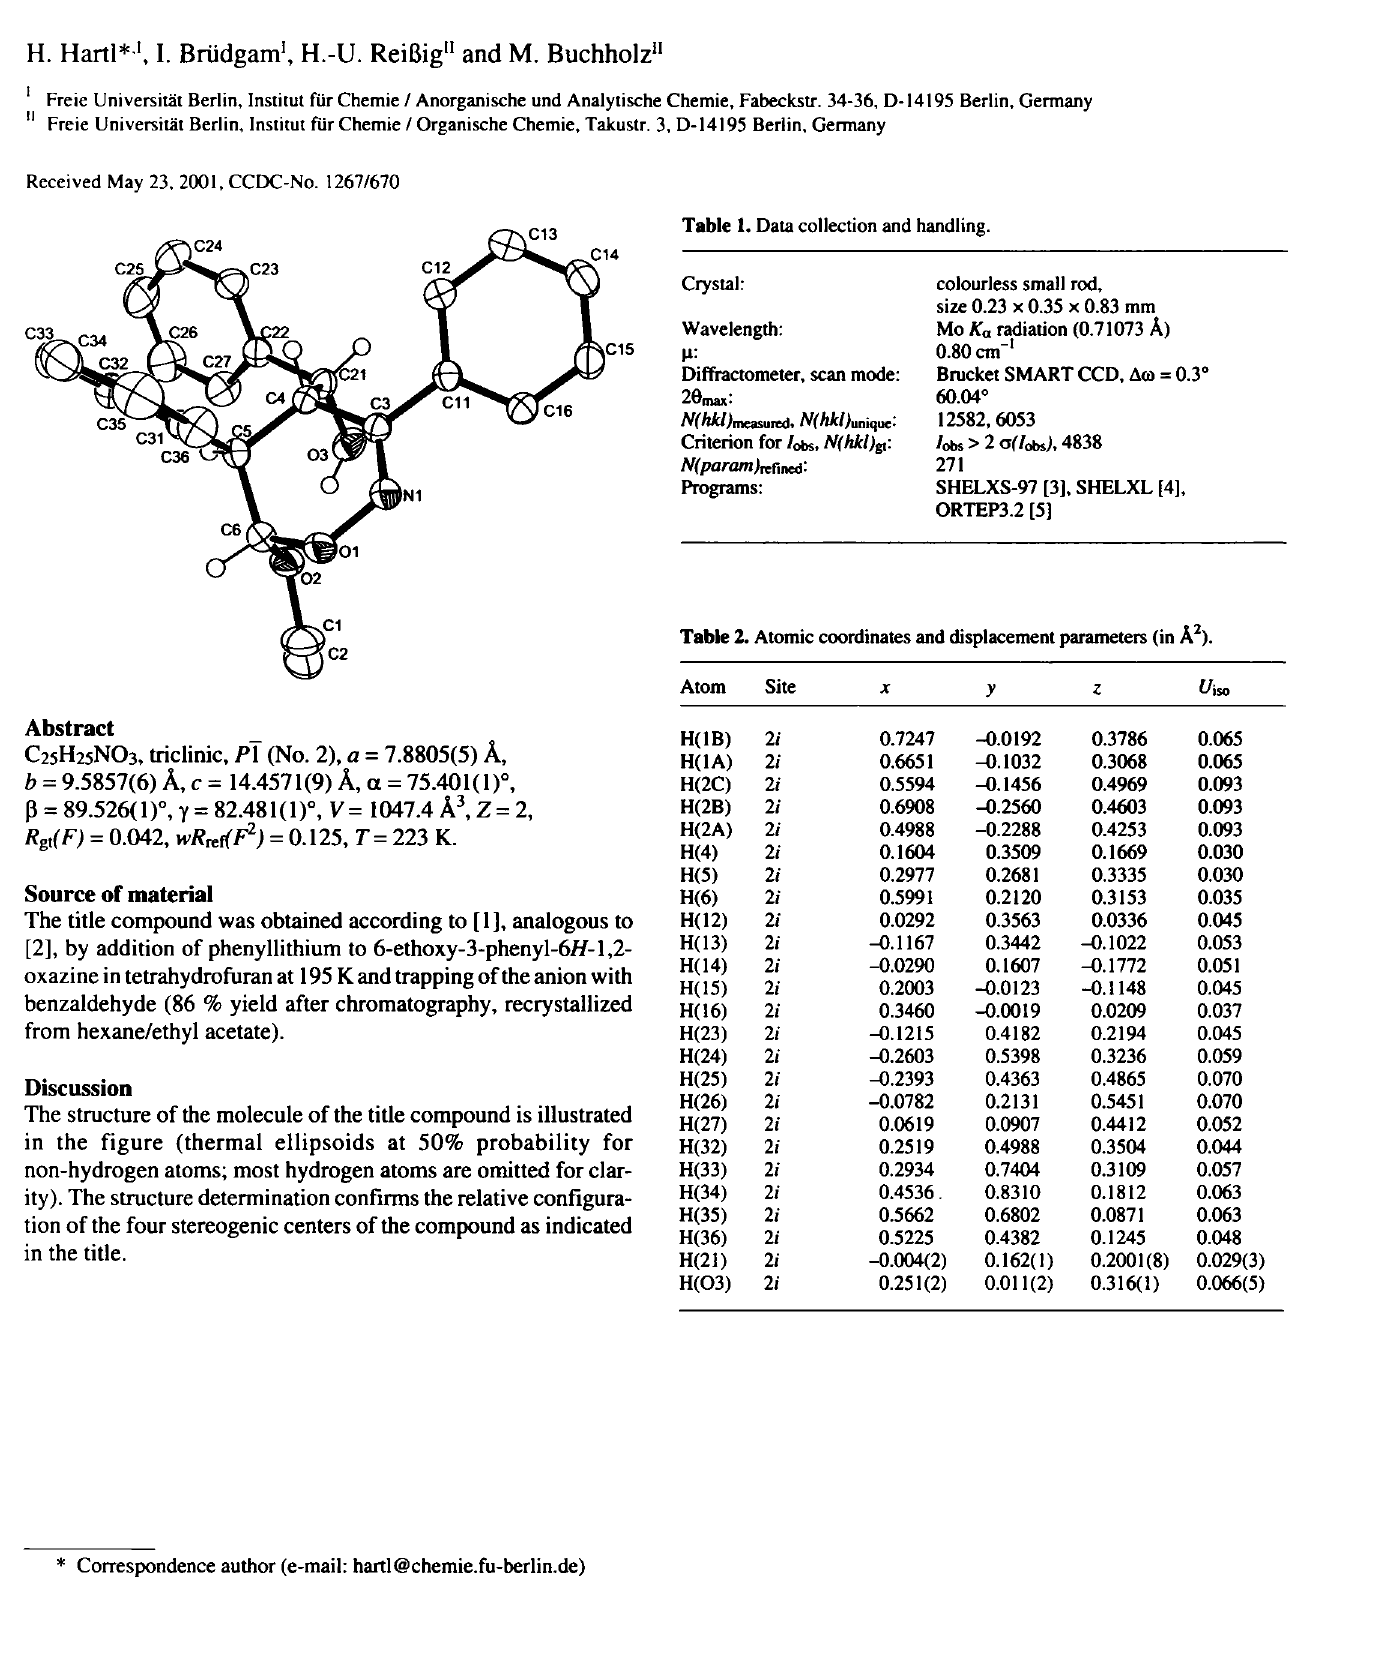
Table 1. Data collection and handling.